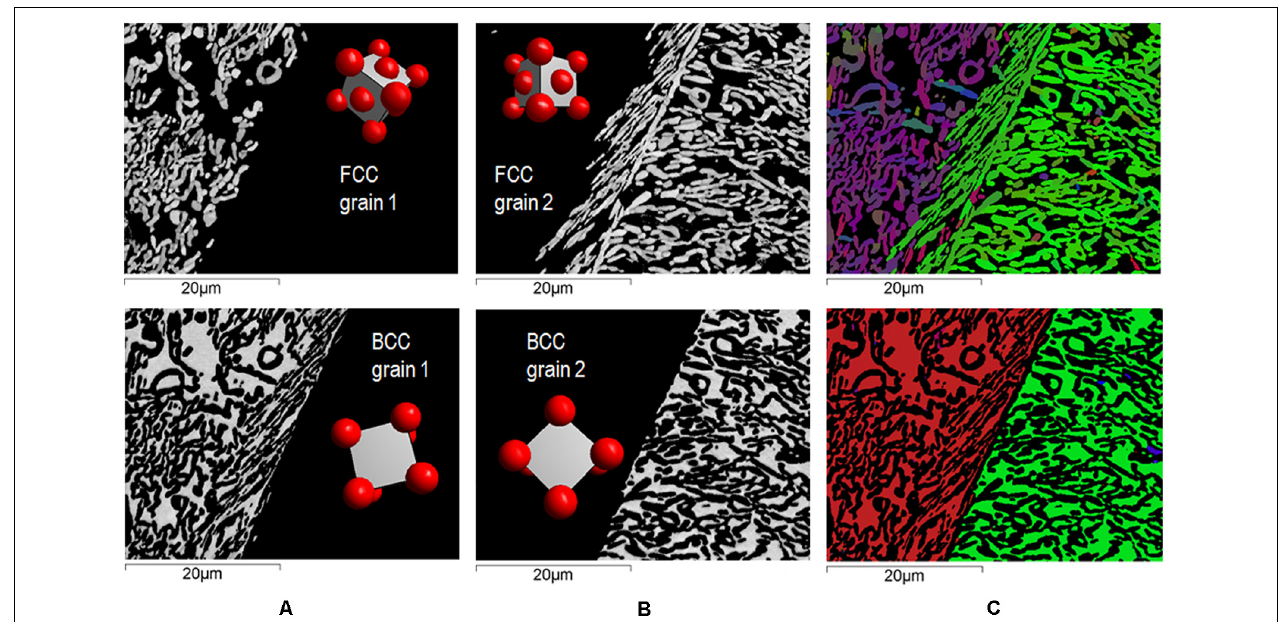
FIGURE 3 | EBSD map in sample AlCrFe 2 Ni 2 with ultrafine vermicular microstructure in a region of interest containing a grain boundary of the parent BCC-B2 phase. The phases and their crystal mimic are shown for each grain (A,B) . An overall view is presented in (C) using an inverse pole figure color map for the FCC phase (top) and the BCC phase (bottom),